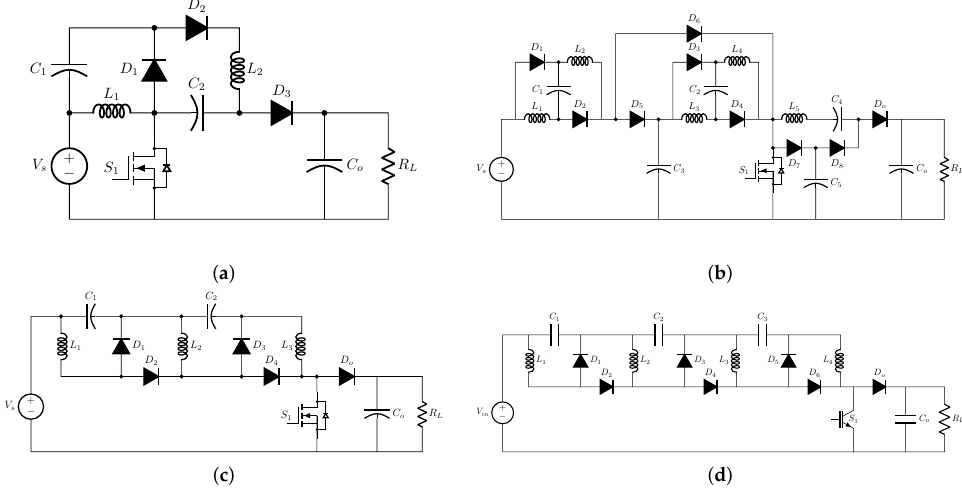
Figure 13. Voltage Lift (VL) Techniques. ( a ) Boost Converter based on VL, ( b ) QBC based on Voltage Doubler and VL, ( c ) QBC based on elementary VL (Double Lift) and ( d ) QBC based on elementary VL (Triple